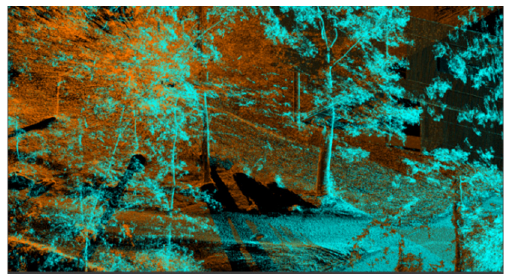
Figure 15. TLS LiDAR clouds in the tree-lined area of the UPV/EHU DSS campus. Forest biomass data can be obtained from these clouds, which offset the lack of ALS LiDAR clouds.